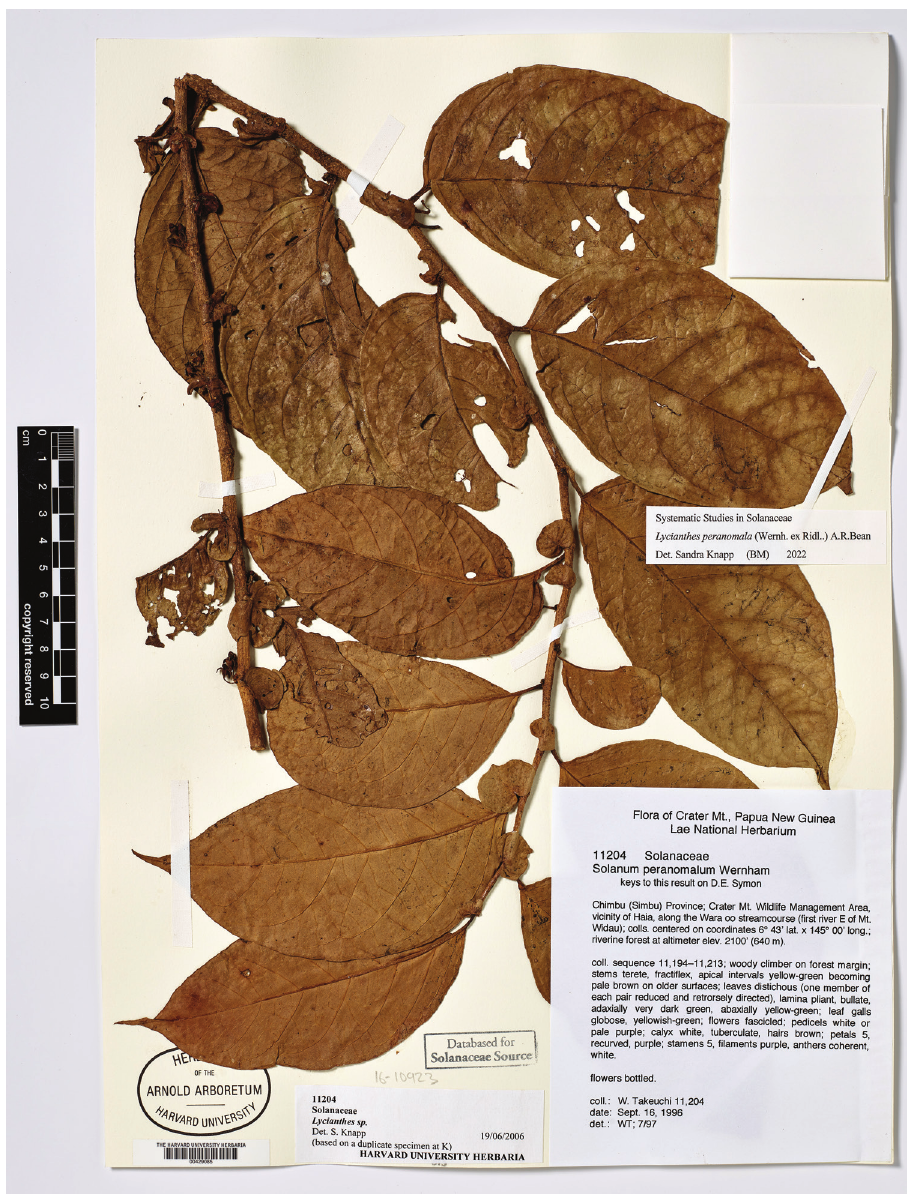
Figure 41. Lycianthes peranomala herbarium specimen. Papua New Guinea. Chimbu: Takeuchi 11204 (A). Courtesy of the Herbarium of the Arnold Arboretum of Harvard University, reproduced with